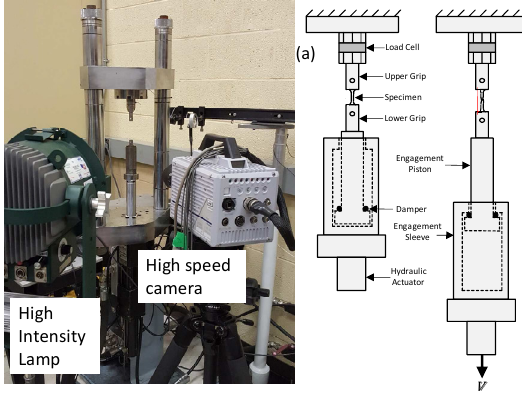
Fig. 3. HISR Apparatus with high speed DIC system.